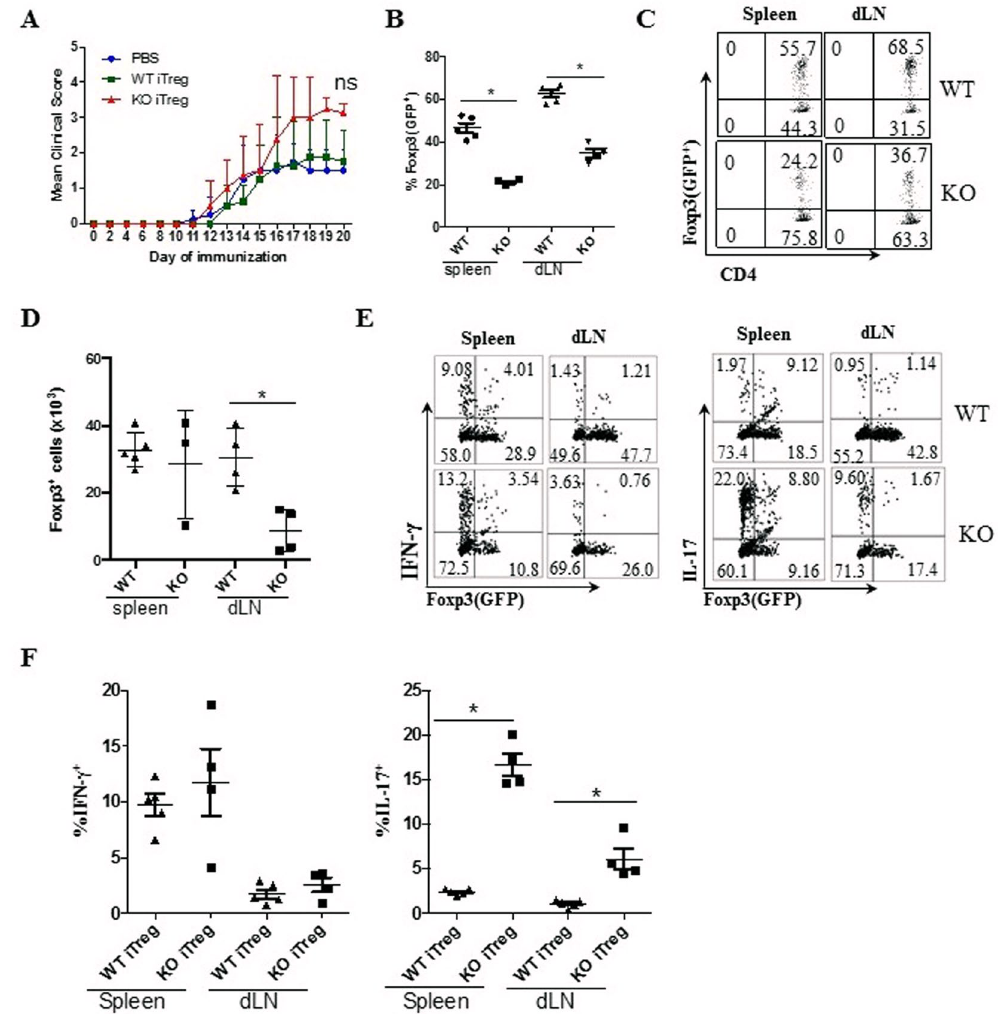
Figure 4. Effect of PD-1H on the stability of iTreg cells in the EAE model. ( A ) CD45.2 + Foxp3(GFP + ) iTreg cells from WT or KO were obtained by cell sorting after induction in vitro . 1 × 10 6 WT or PD-1H KO Foxp3 (GFP + ) iTreg cells were transferred i.v. into the CD45.1 B6 mice (n = 4 or 5 per group) before the immunization with MOG 35–55 peptide. Control mice were inoculated with PBS. EAE disease progression and severity was monitored as clinical score (see Methods). * P < 0.05, (two-way ABOVA test). Data shown represent 1 of 3 experiments with similar results and disease phenotypes. ( B , C ) The spleen and draining LN (dLN) cells at Day 13 of EAE induction were gated on CD45.2 + CD4 + and analysed for Foxp3 (GFP + ) iTreg cells. ( D ) Absolute numbers of CD45.2 + Foxp3 + in the spleen and dLN from the EAE mice were counted. ( E ) The spleen and dLN cells from EAE mice at day 13 were re-stimulated ex vivo using PMA/Ionomycin/BFA for 4 hours. Cells were gated on CD4 + CD45.2 + GFP + for analysis of IFN- γ + or IL-17 + expression using intracellular staining. The data from a representative pair of mice are shown. ( F ) Graphic presentation of data in ( E ) shown in a group of 4 or 5 mice. Data shown are representative of at least 3 independent